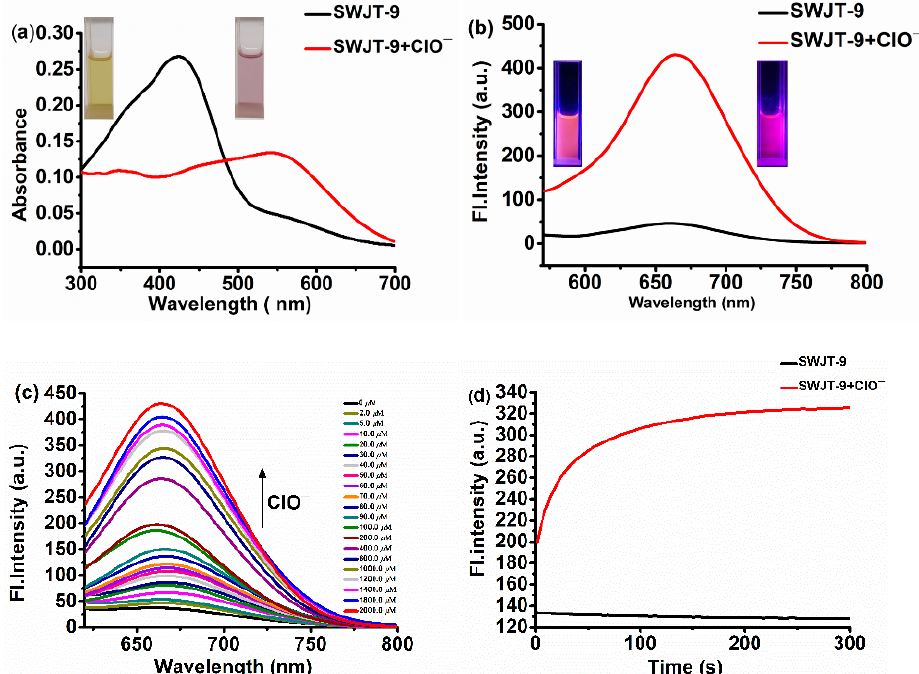
Figure 1. ( a ) Absorption spectra of SWJT-9 (10.0 μ M) and SWJT-9 + ClO − (2.0 mM) in EtOH–PBS (9/1, v / v , pH 7.4) buffer solution. Inset: images of SWJT-9 (left) and SWJT-9 after adding ClO − (right) under visible light. ( b ) Fluorescence spectra of SWJT-9 (10.0 μ M) and SWJT-9 + ClO − (2.0 mM) in EtOH–PBS (9/1, v / v , pH 7.4) buffer solution ( λ ex = 550 nm). Inset: images of SWJT-9 (left) and SWJT-9 + ClO − (right) after adding ClO − under UV light. ( c ) Fluorescence titrations of SWJT-9 (10.0 μ M) with different concentrations of ClO − (0–2000.0 μ M) ( λ ex = 550 nm). ( d ) The fluorescence intensity of the SWJT-9 (10.0 μ M) and ClO − (2.0 mM) probes increased with time ( λ em = 667 nm).